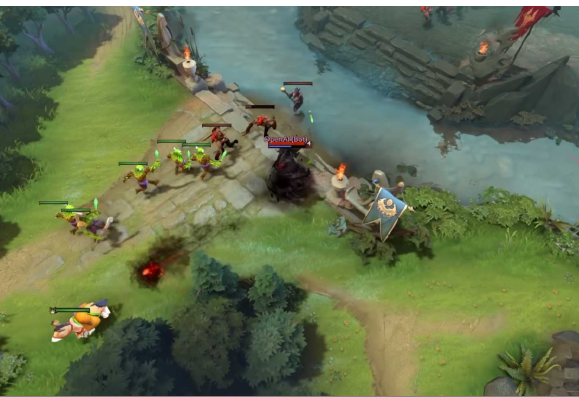
Figure 12. OpenAI Five wins back–to–back games versus Dota 2 world champions OG at Finals, becoming the first AI to beat the world champions in an esports